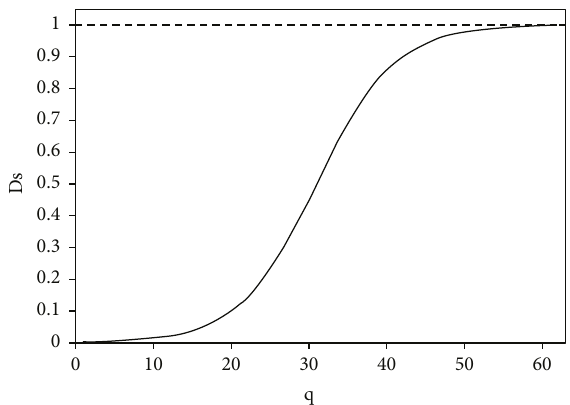
Figure 6: Functional response: probability of hunted prey Ds q versus size of predator population q